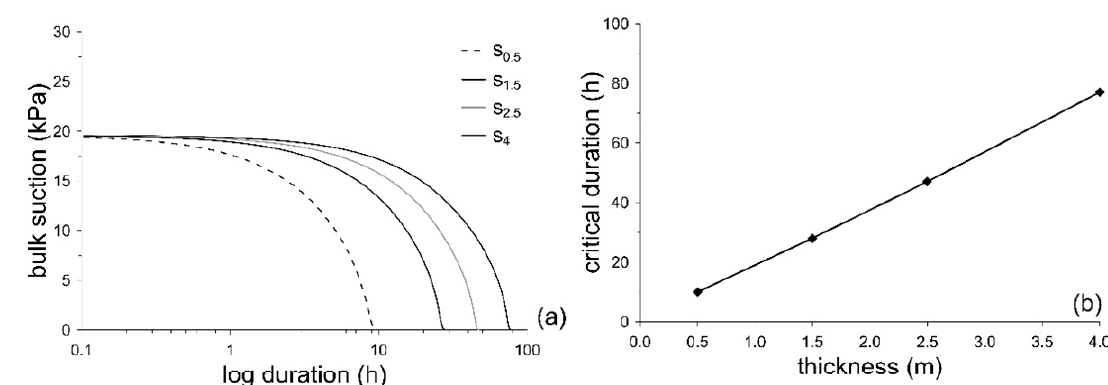
Figure 7. Results of set A analyses: ( a ) suction evolution for four different domain thicknesses induced by critical events; ( b ) critical duration against domain thickness.